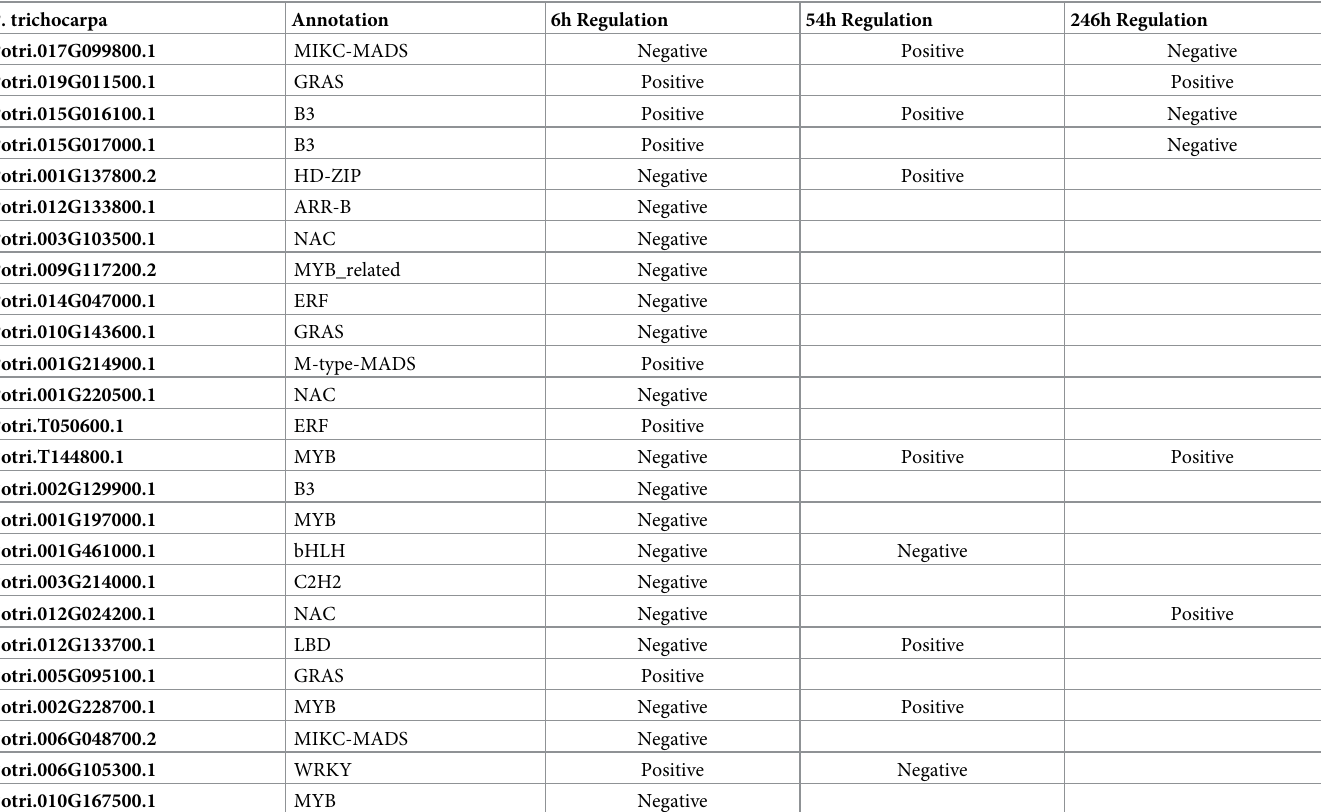
Table 2. Transcription factors related to aluminium stress. P.